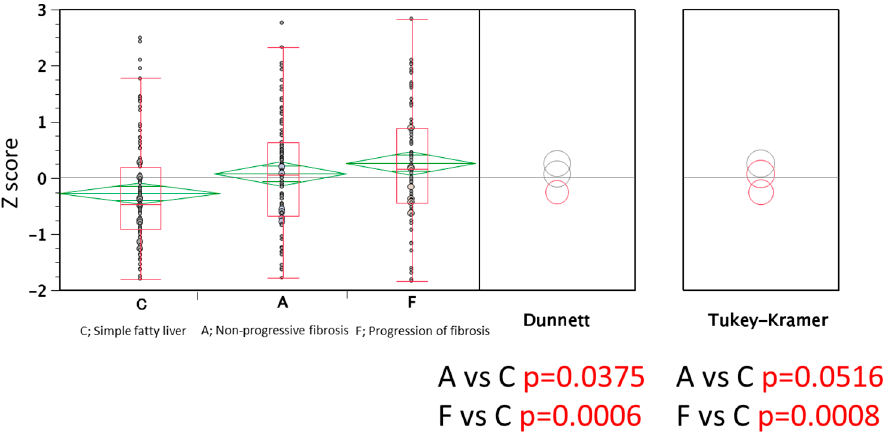
Figure 5. Relationship between progression of fibrosis and methylation levels in non-cancerous liver tissue. Methylation levels in the background liver from severe fibrosis and those from mild fibrosis were higher than those in the control. In contrast, the methylation levels in severe fibrosis and mild fibrosis were similar.